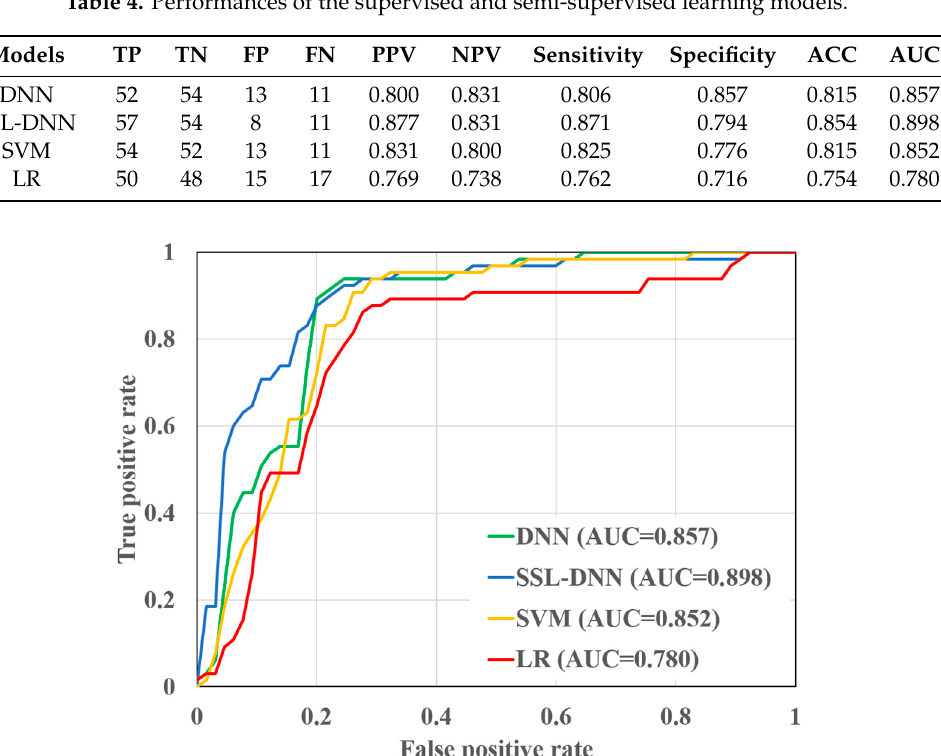
Table 4. Performances of the supervised and semi-supervised learning models.